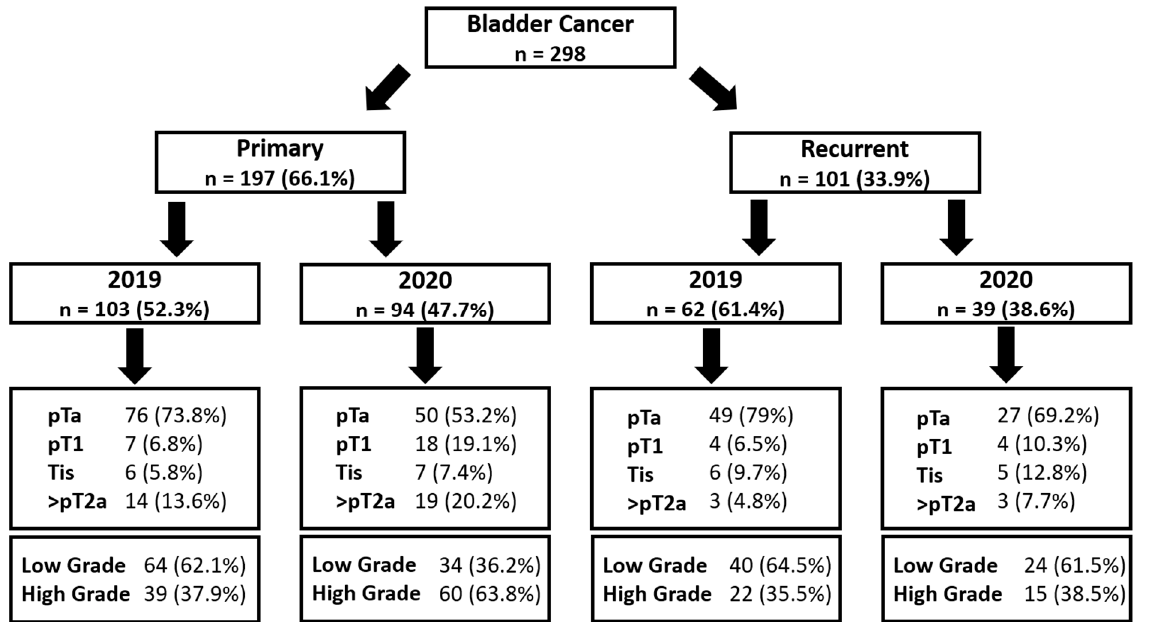
Figure 5. All diagnosed cancer cases stratified into primary bladder cancers and recurrent tumors, compared for the years 2019 and 2020.